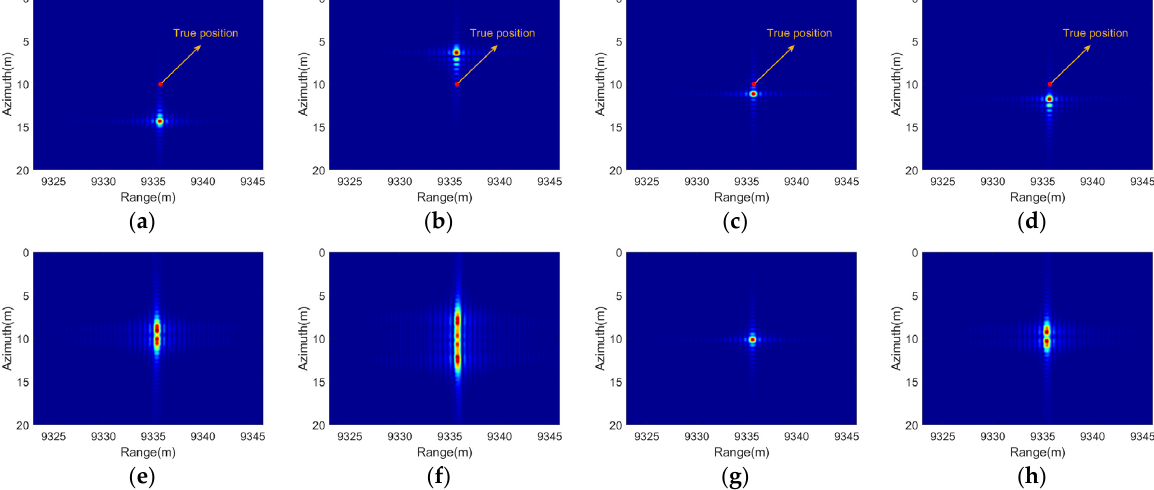
Figure 15. Focusing results of the point target with angular oscillations of the carrier on sea-state 5. ( a ) Roll motion, Ψ x = 0; ( b ) pitch motion, Ψ y = 0; ( c ) yaw motion, Ψ z = 0; ( d ) all the three angular oscillations exist, Ψ x = Ψ y = Ψ z = 0; ( e ) roll motion, Ψ x = π /2; ( f ) pitch motion, Ψ y = π /2; ( g ) yaw motion, Ψ z = π /2; ( h ) all the three angular oscillations exist, Ψ Ψ Ψ x = y = z = π .